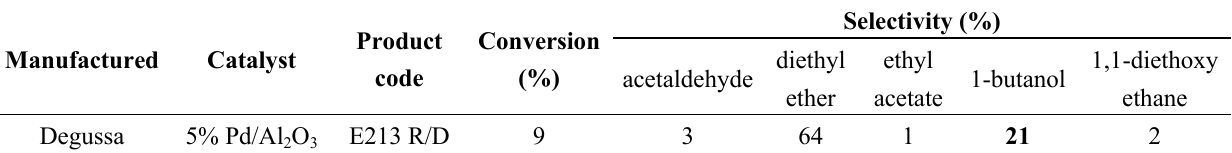
Table 5. Results obtained with alumina supported Pd